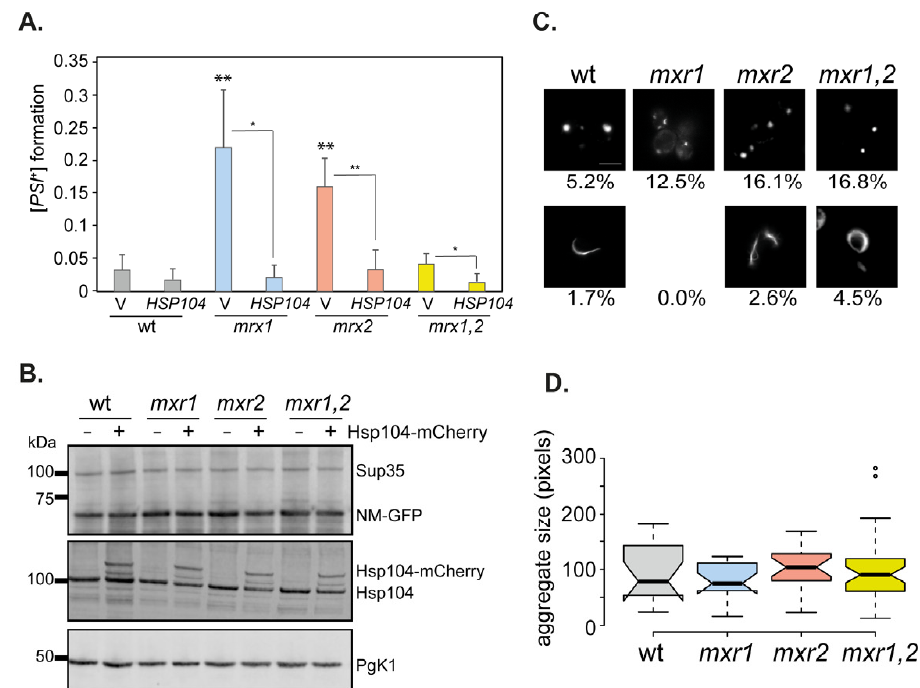
Figure 6. Overexpression-induced [ PSI + ] prion formation is increased in single but not double MXR mutant strains. ( A ) [ PSI + ] prion formation was quantified in the wild-type and MXR mutant strains containing vector alone or expressing Hsp104 under the control of the constitutively active TDH3 promoter. Prion formation was induced by inducing Sup35NM-GFP expression following 20 h of copper induction. Data shown are the means of three independent biological repeat experiments expressed as the number of [ PSI + ] cells per viable cell. Error bars denote standard deviation. Signif- icance was tested using an unpaired t-test, and pairwise comparisons are for the wild-type strain and MXR mutants containing the vector, or each strain comparing vector with HSP104; * p < 0.05, ** p < 0.01. ( B ) Western blot analysis of the same strains probed with α Sup35 (endogenous Sup35 and NM-GFP), α Hsp104 (endogenous Hsp104 and Hsp104-mCherry), or α -Pgk1 as a loading control. ( C ) Fluorescence micrographs showing examples of puncta or rod- and ribbon-like aggregates formed in the wild-type and MXR mutant strains expressing Hsp104 under the control of the constitutively ac- tive TDH3 promoter. Prion formation was induced by inducing Sup35NM-GFP expression following 20 h of copper induction. The percentage of cells containing visible puncta or rod- and ribbon-like aggregates is indicated. ( D ) The GFP-positive areas were quantified for puncta formed in panel ( C ). At least 16 puncta were measured from each strain.